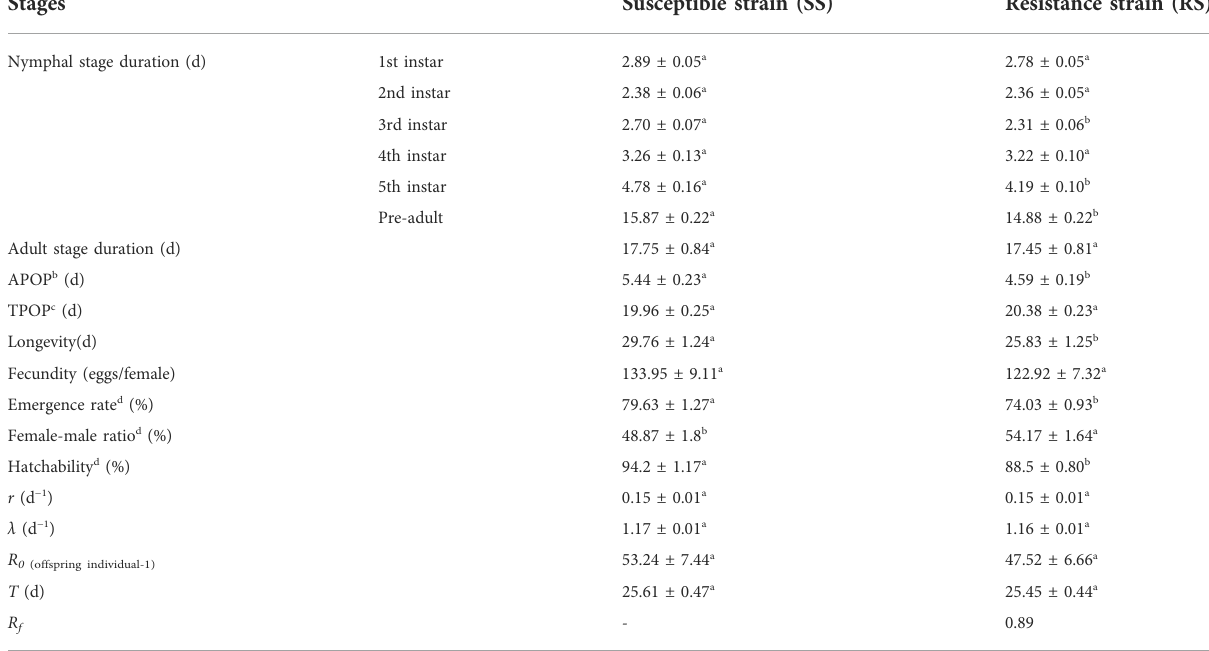
TABLE 5 Duration of the development and life table parameters for the SS and RS strains of SBPH a .